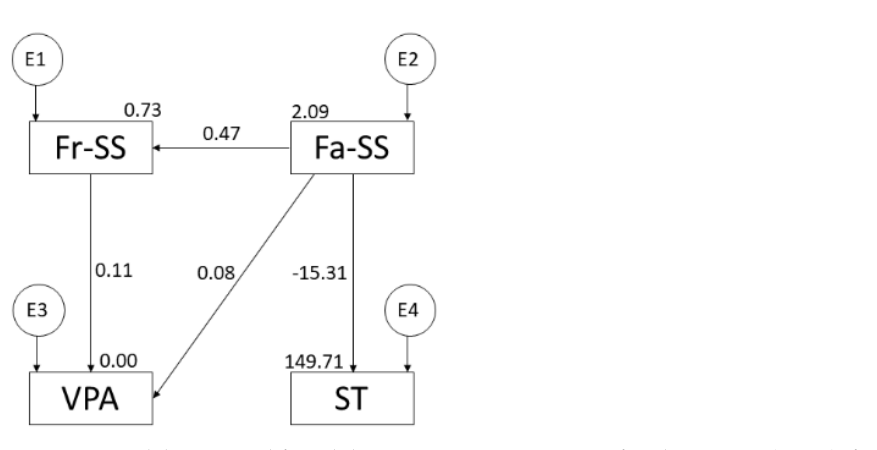
Figure 4. Model suggested for adolescent vigorous-PA. Note: family support (Fa-SS); friend support (Fr-SS); vigorous physical activity (VPA); screen time